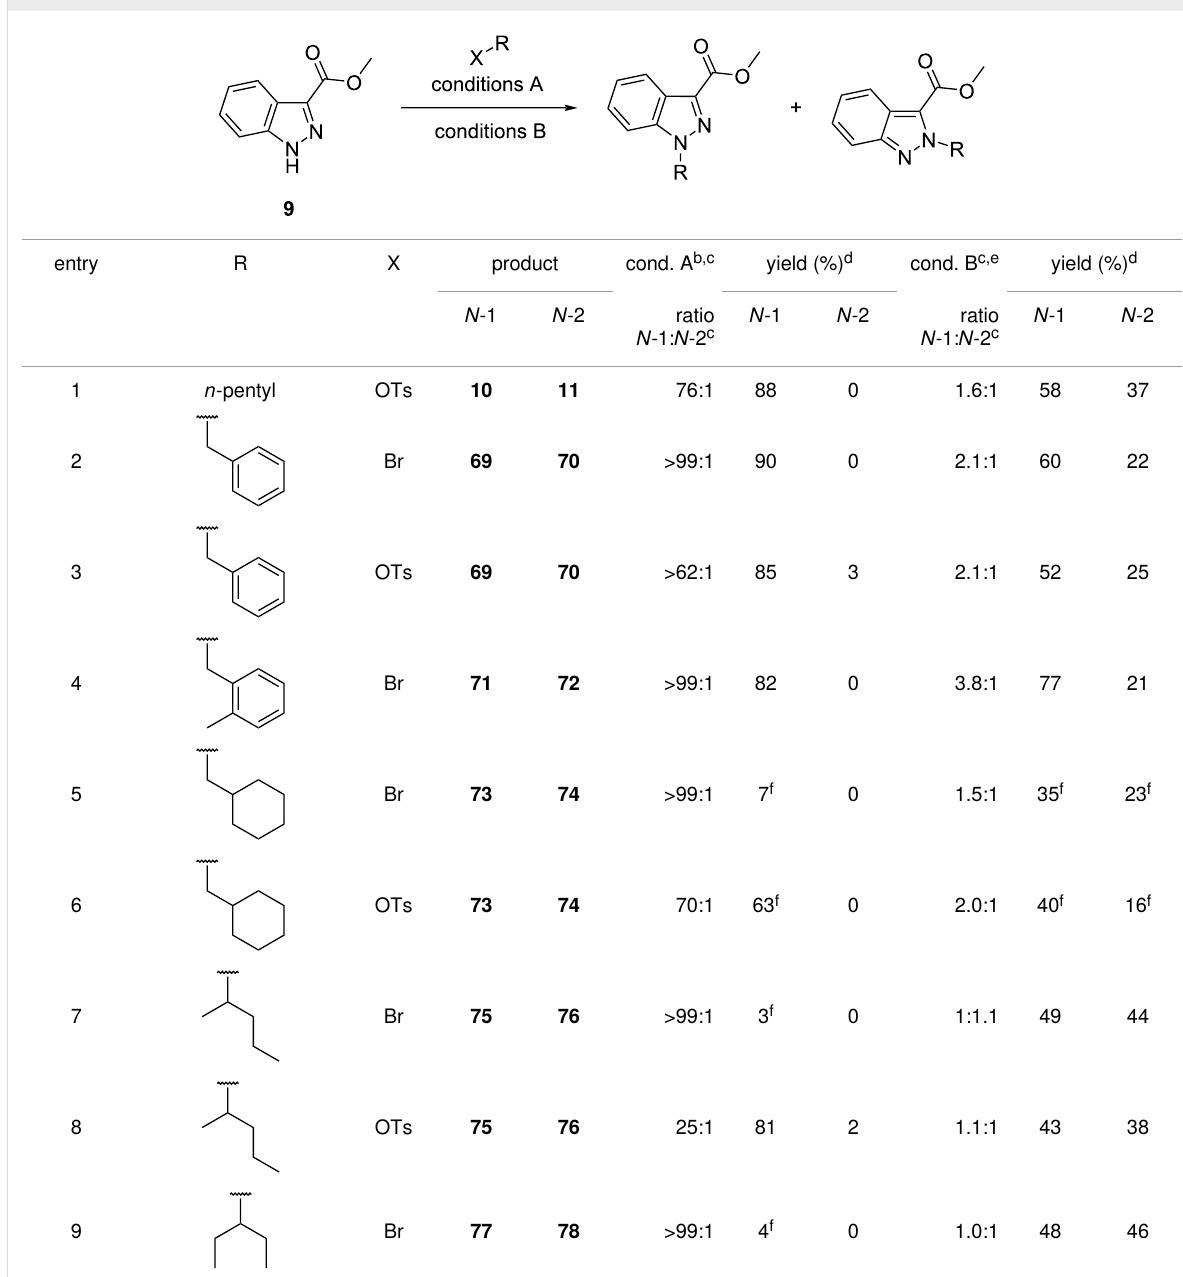
Table 6: Alkylating reagent effects on N -1/ N -2 regioselectivity.